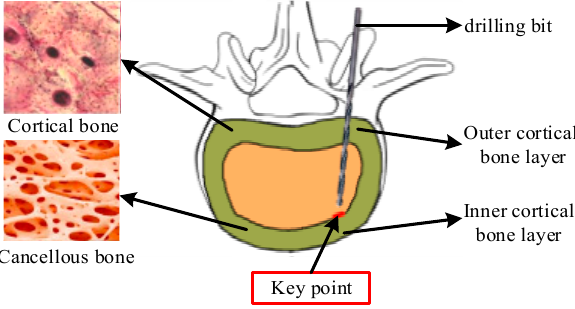
Figure 1. The structure of single segment in pedicle and the bone drilling in the spine pedicle, where light green represents the cortical bone and canary yellow represents the cancellous bone.